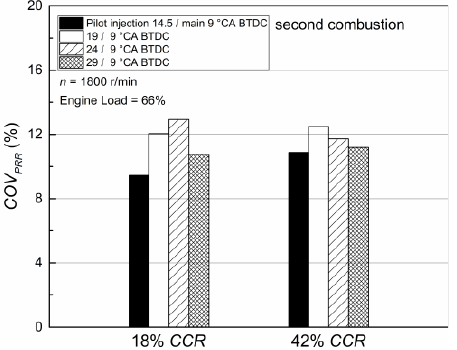
Figure 7. COV PRR of second combustion stage under different pilot injection timings.